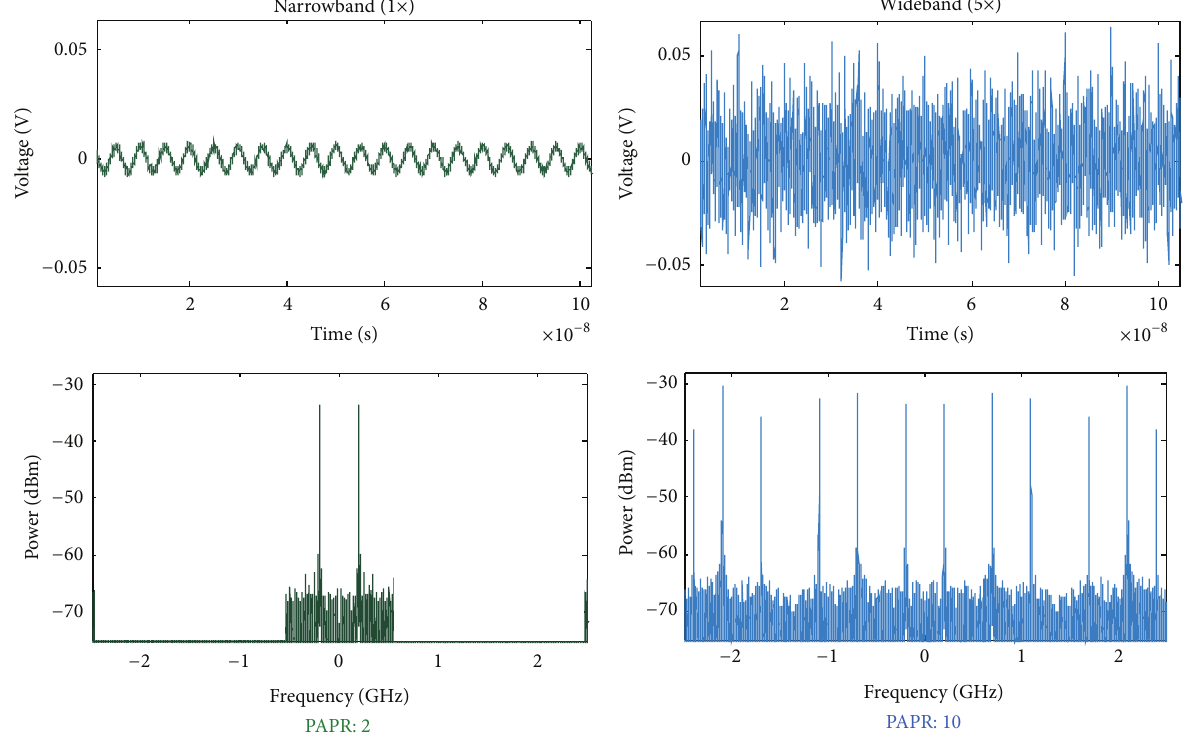
Figure 4: PAPR increase in wideband signals compared to narrowband signals.